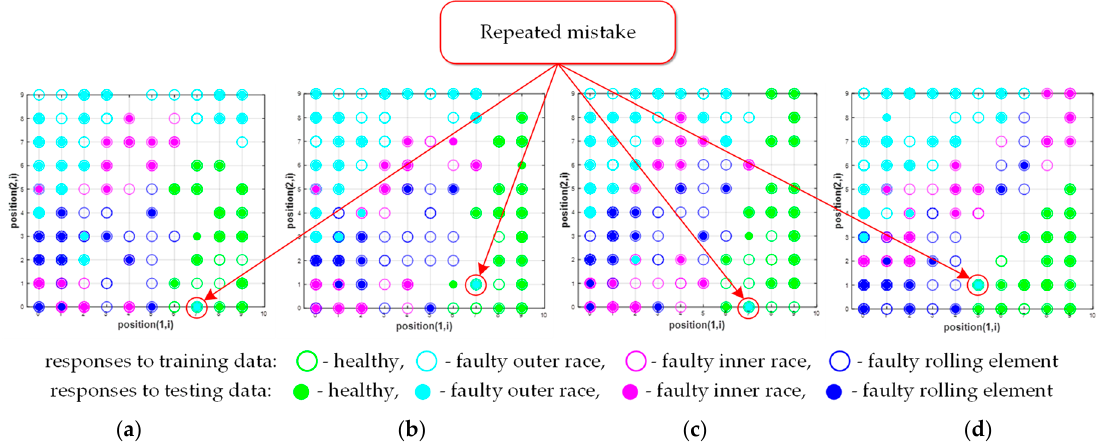
Figure 17. The results of the SOM classifier for the 10 × 10 hexagonal map and the linkdist distance function for different values of the neighbourhood radius: 2 ( a ), 6 ( b ), and for different distance function: linkdist ( c ), dist ( d ) with the neighbourhood radius equal to 2.